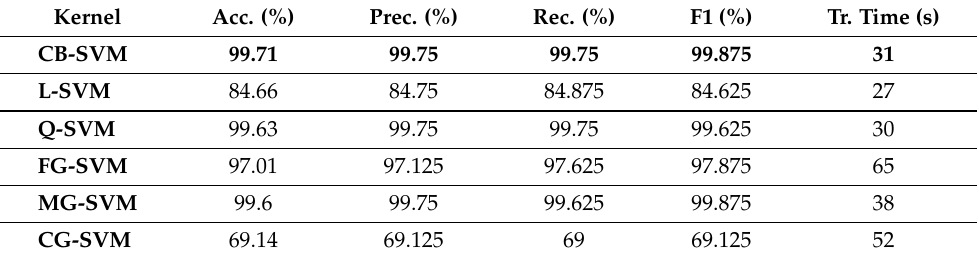
Table 4. Performance evaluation of classifiers used in the proposed model.